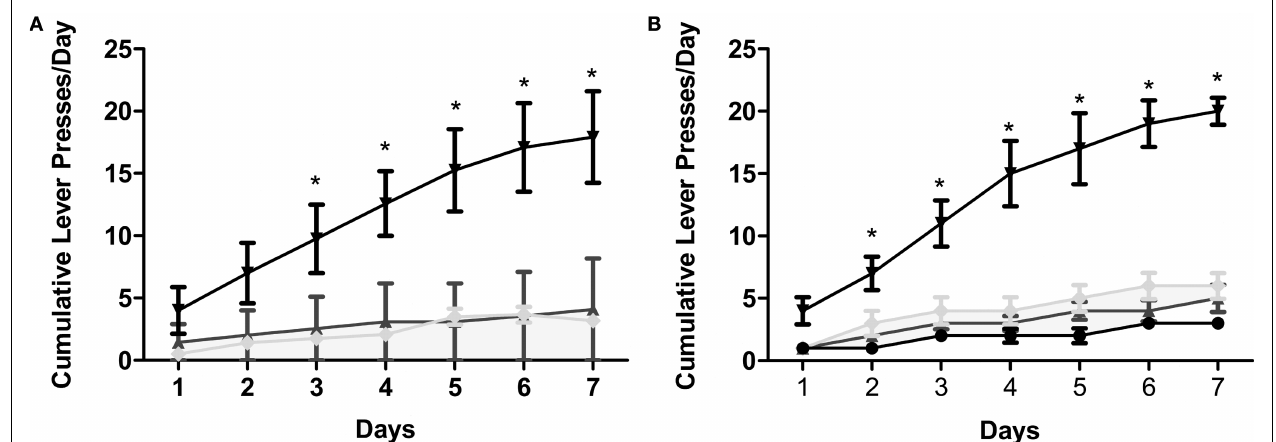
FIGURE 3 | Intrahippocampal METH sustains self administration. (A) Cumulative lever presses per day on the active and inactive levers during the 30-min test sessions across 7 days. Rats in the Ringer’s ( n = 11) and METH 10 µg/µl ( n = 12) groups were co-treated with 250 µM SCH during days 5–7. METH 10 µg/µl group active lever presses were signifi cantly greater than Ringer’s group active lever presses from day 3 onward. METH group: upside-down black triangles; METH inactive: light gray diamonds; Ringer’s: dark gray triangles. (B) METH